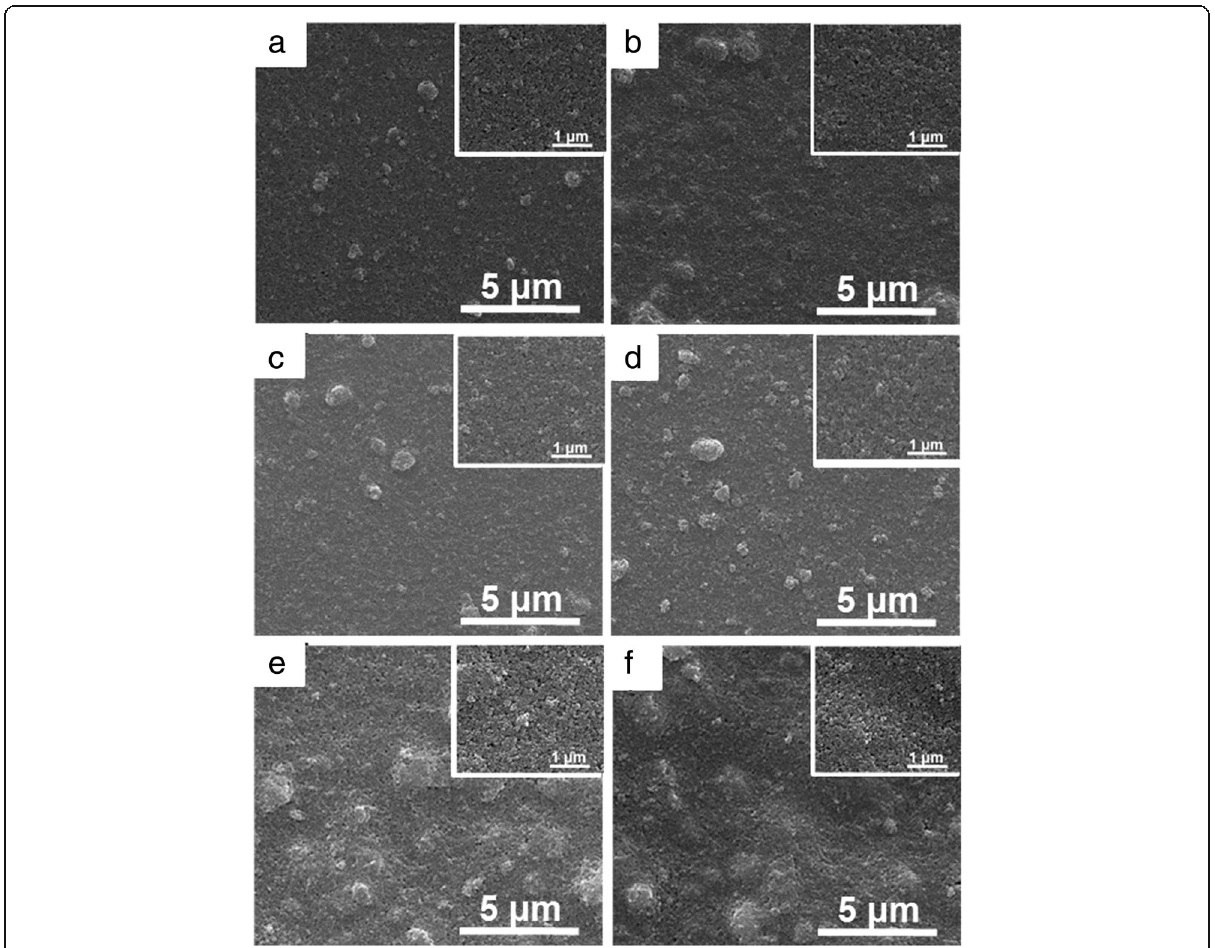
Fig. 7 (Color online) SEM images of modified FTO electrodes under different fabrication conditions, including a lifting speed of 2000 μ m/s, b lifting speed of 1000 μ m/s, c precursor concentration of 1:3, d precursor concentration of 1:4, e dipping number of 3, and f dipping number of